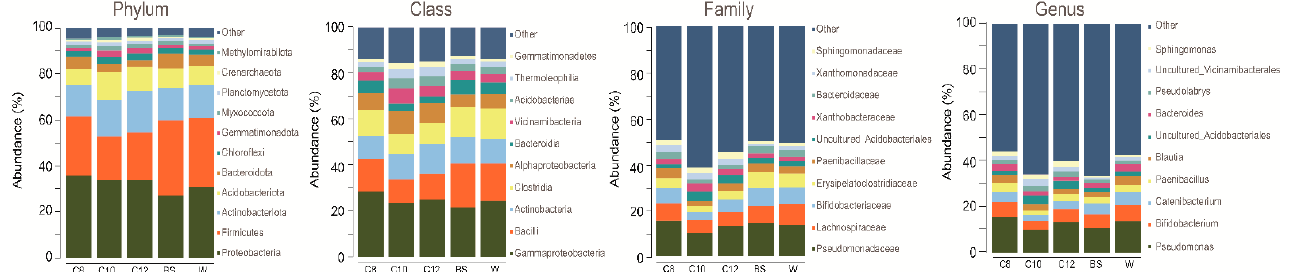
Figure 2. Relative abundance of different samples. A represents the relative abundance of the phylum, class, and family, and genus level.